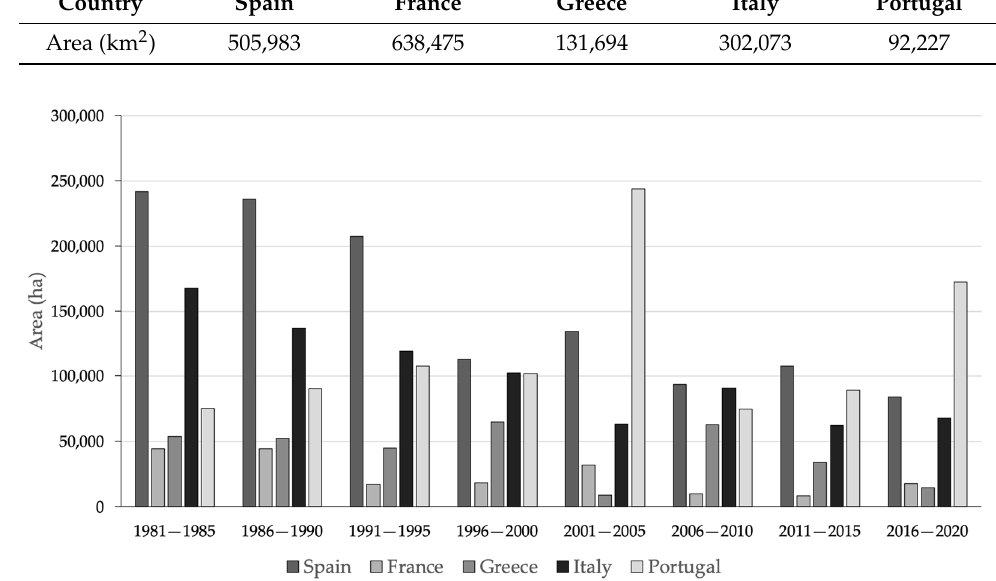
Figure 2. Average burnt area (hectares) per five-year period in five southern European countries (adapted from http://www.pordata.pt, accessed on 14 December